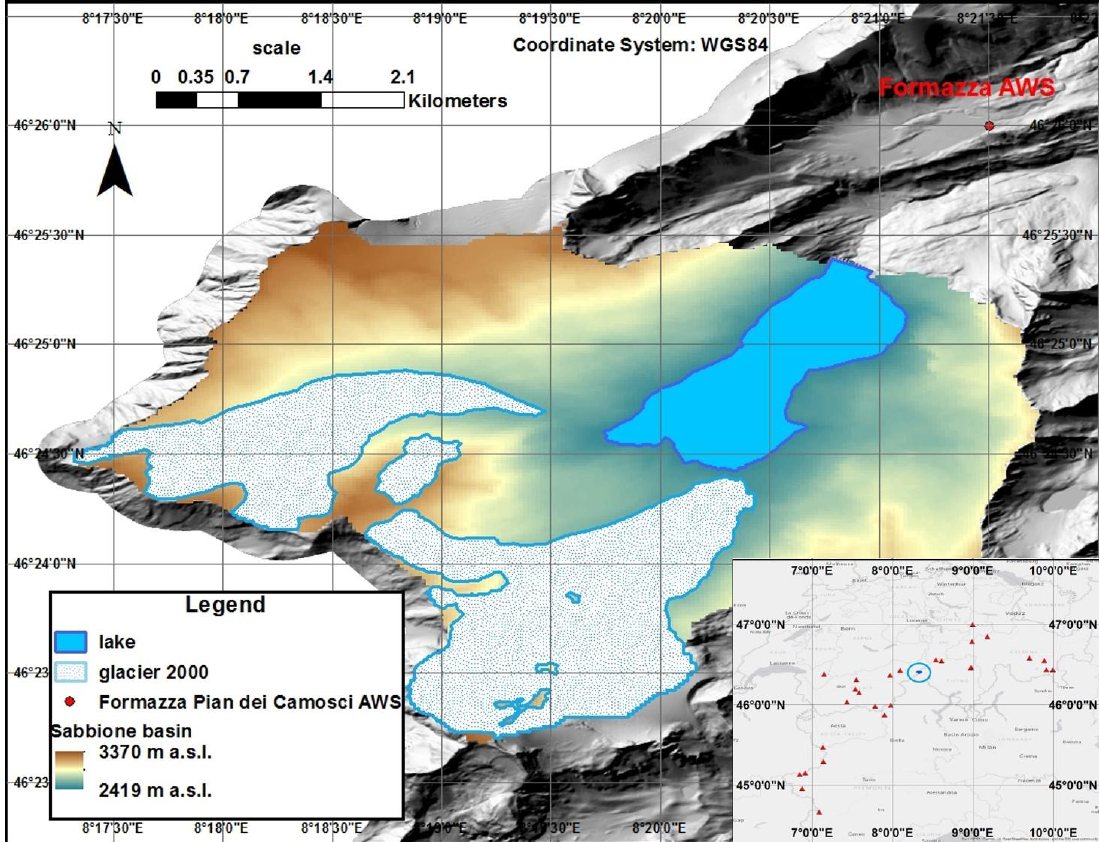
Figure 1. Case study area. Sabbione artificial lake, and glaciers’ outline (in year 2000). Closest automatic weather station (AWS) station (Formazza) reported, used for weather driven Poly-Hydro simulation. On the lower right the red triangles are temperature station used for downscaling and the blue circle contains the Sabbione basin.